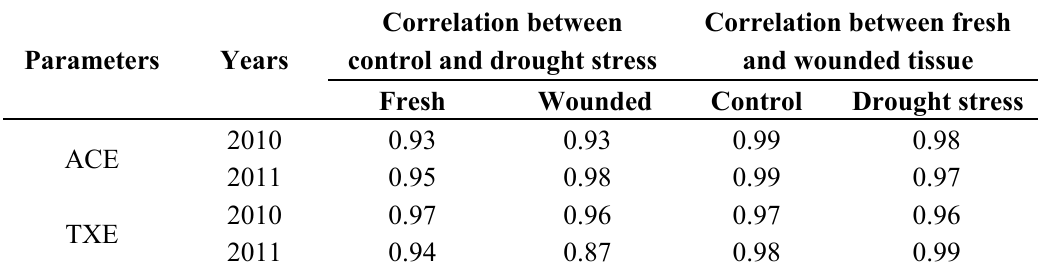
Table 8. Correlations between control and drought stressed tubers, and correlations between fresh and wounded tubers for ACE and TXE measured in 2010 and